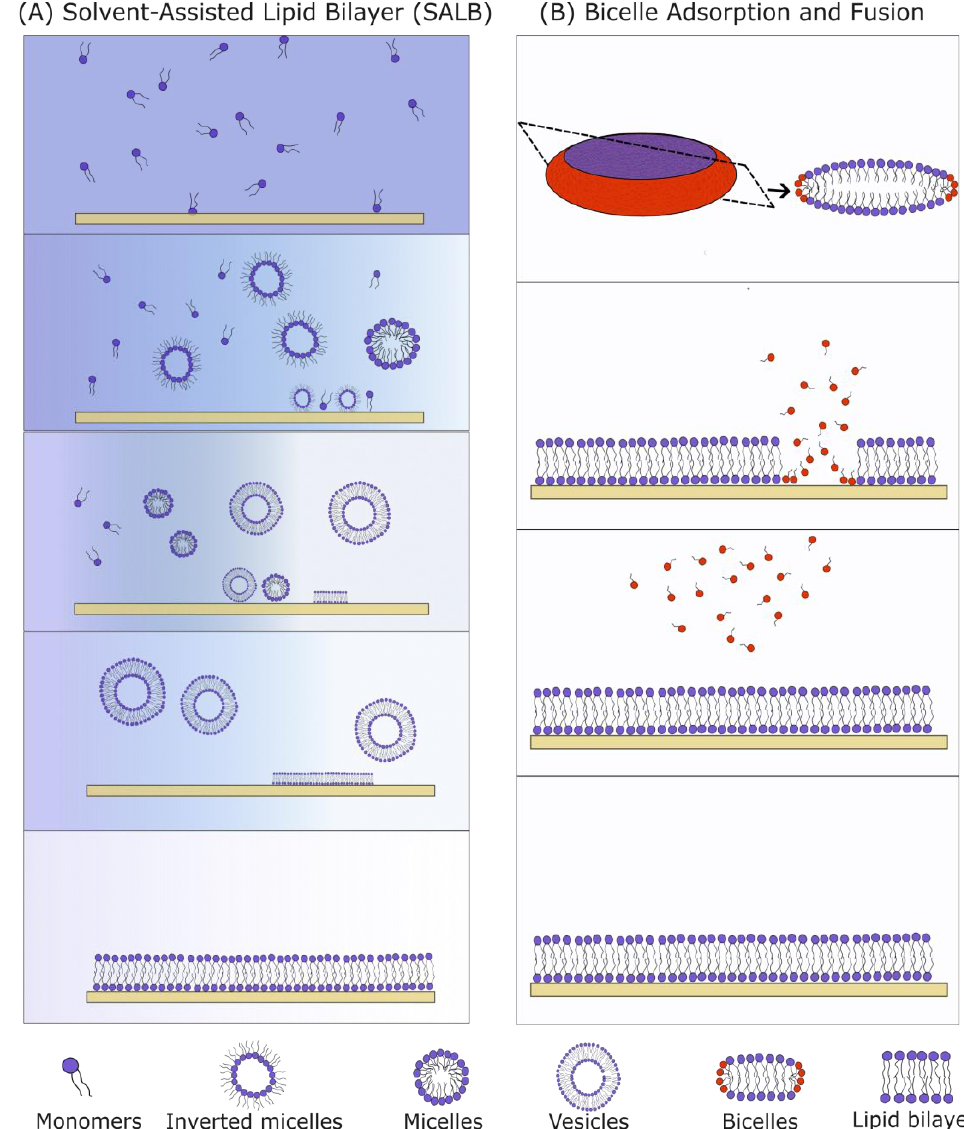
Figure 8. Comparison of the SALB ( A ) and bicelle method ( B ) for formation of SLBs. ( A ) The SALB method begins when long-chain PLs are dissolved in a water-miscible organic solvent. The organic solvent is gradually exchanged with the aqueous solvent. During the solvent exchange, the lipids first assemble into inverted micelles and later into micelles and vesicles. These attach themselves to the surface and rupture to form an SLB. ( B ) Bicelles are disk-like structures containing both long-chain (blue) and short-chain (red) lipids. If there is an attractive force between the substrate and the bicelles, they are adsorbed onto the surface and fuse together. Long-chain PLs remain attached to the substrate, and short-chain PLs are washed away in the form of monomers using a buffer. Bicelle-mediated SLB formation is another approach that can be used for the fabrica- tion of SLBs with a high Chol content. Bicelles are lipid structures with a disc-like shape, containing a mixture of long-chain and short-chain lipids (Figure 8B). The first publication on bicelle-mediated SLBs was conducted by Zeineldin et al. in 2006, using 1,2-dipalmitoyl- sn -glycero-3-phosphocholine (DPPC) and 1,2-dihexanoyl- sn -glycero-3-phosphocholine li- pids [73]. The main advantage of the method is the ease of the bicelles preparation. A dry lipid film containing a mixture of long-chain and short-chain PLs is hydrated in an aque- ous solution and then vortexed. After mixing, the solution is frozen in liquid nitrogen,